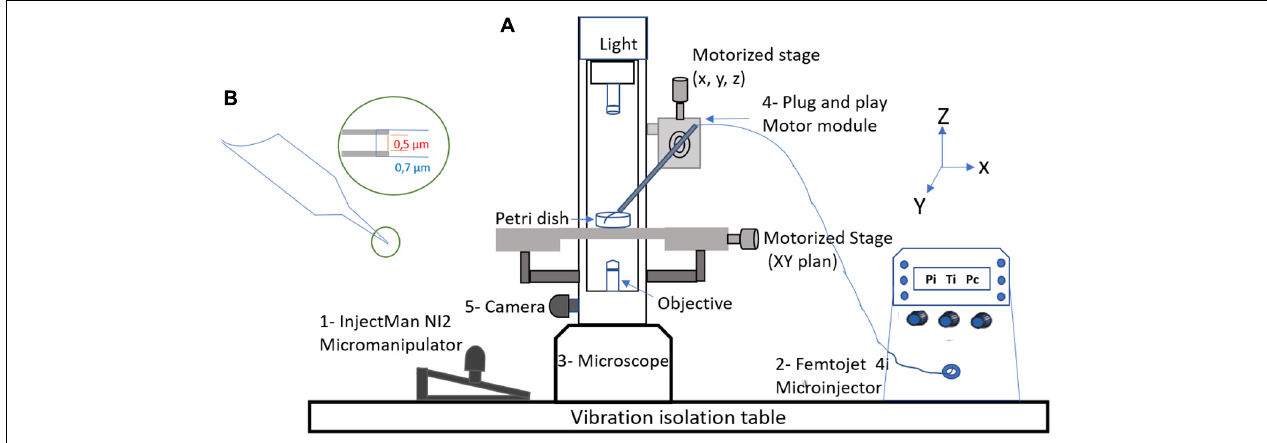
FIGURE 1 | Micromanipulation equipment. (A) Components of workstation: 1—InjectMan NI2 micromanipulator which allows for the positioning of the micropipette (Eppendorf Equipment, France), 2—FemtoJet 4i microinjector (Eppendorf, France), 3—Eclipse TE 2000S Inverted microscope (Nikon, France), 4—plug and play motor modules, and 5—DFC 425C camera (Leica, Germany). (B) Femtotips with an inner diameter of 0.5 µ